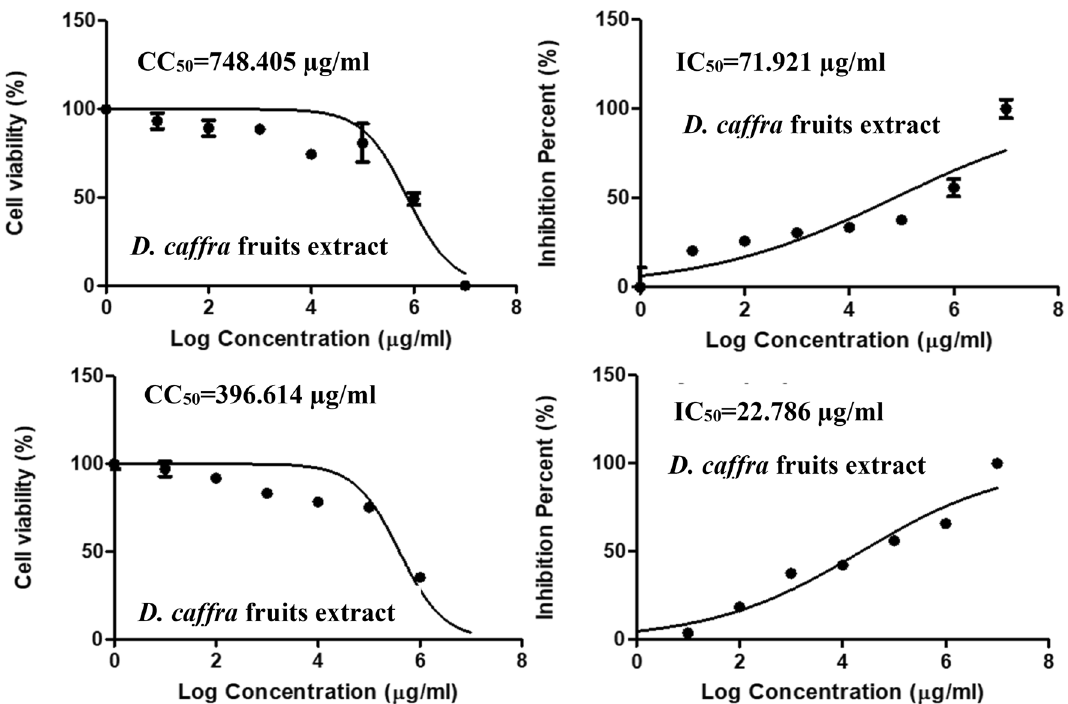
Figure 7. Effect of D. caffra fruits extract on Coronavirus 229E with Acyclovir as a positive